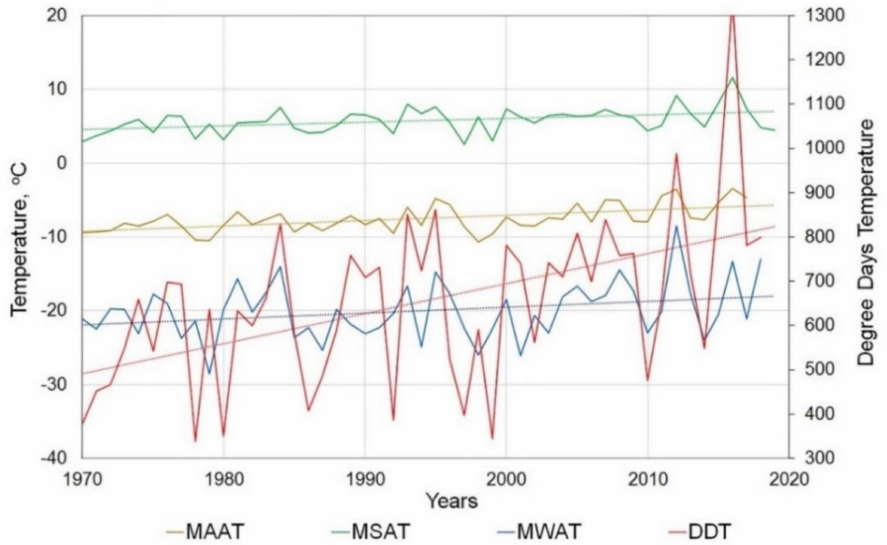
Figure 2. Change in mean annual temperature (MAAT), summer temperature (MAST), winter temperature (MAWT), and thawing index (DDT, degree-days above 0 ◦ C, calculated as cumulative number of all the positive mean daily air temperatures during a calendar year) over time, based on the data obtained from the Marre-Sale weather station, 1970–2019. Dotted lines show linear trends in changes of climatic